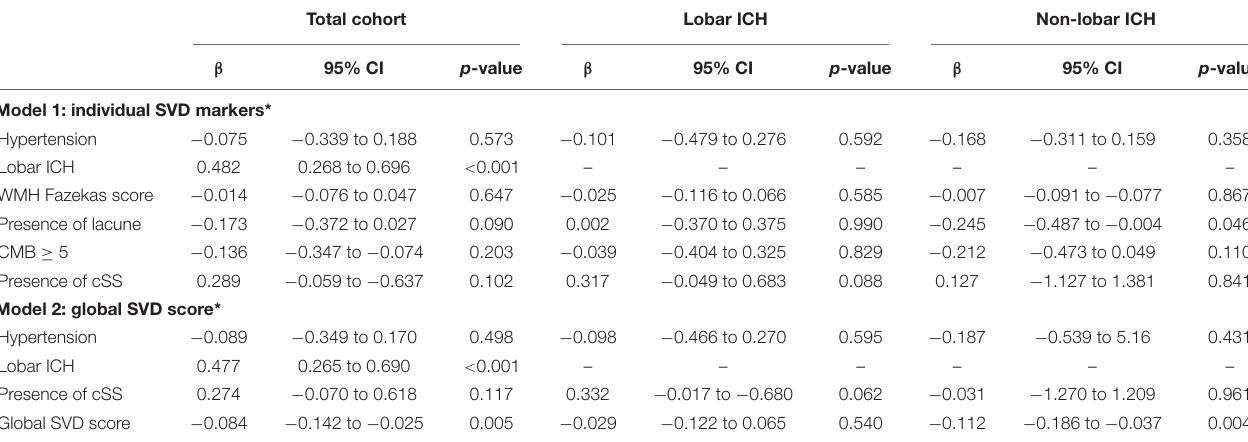
FIGURE 3 | Simple linear regression model of log-transformed hematoma volume and global SVD score in lobar and non-lobar ICH. The dependent variable was base-10 logarithm of hematoma volume. Log of hematoma volume in non-lobar ICH = -0.133 × Global SVD score + 0.993, p < 0.001. Log of hematoma volume in lobar ICH = -0.013 × Global SVD score + 1.226, p = 0.765. TABLE 4 | The multivariate linear regression analysis of associations between SVD markers and hematoma volume adjusted for age and male sex. Total cohort Lobar ICH Non-lobar